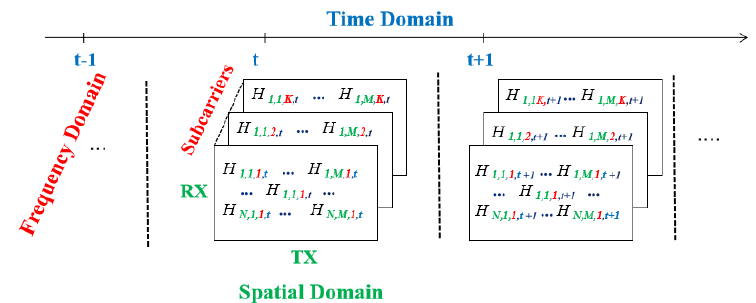
Figure 2. Four-dimensional CSI matrix of MIMO-OFDM channels. Figure 2. Four ‐ dimensional CSI matrix of MIMO ‐ OFDM channels. Table 3. Comparison between RSS and